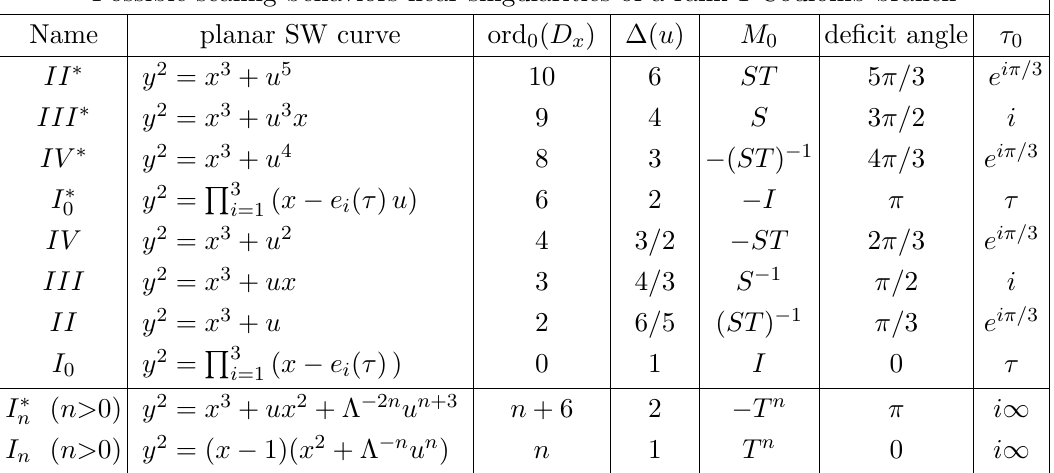
Table 1. Scaling forms of rank 1 planar special Kahler singularities, labeled by their Kodaira type (column 1), a representative family of elliptic curves with singularity at u = 0 (column 2), order of vanishing of the discriminant of the curve at u = 0 (column 3), mass dimension of u (column 4), a representative of the SL(2 ; Z ) conjugacy class of the monodromy around u = 0 (column 5), the de(cid:12)cit angle of the associated conical geometry (column 6), and the value of the low energy U(1) coupling at the singularity (column 7). The (cid:12)rst eight rows are scale invariant. The last two rows give in(cid:12)nite series of singularities which have a further dimensionful parameter (cid:3) so are not scale invariant; they can be interpreted as IR free theories since (cid:28) 0 = i 1